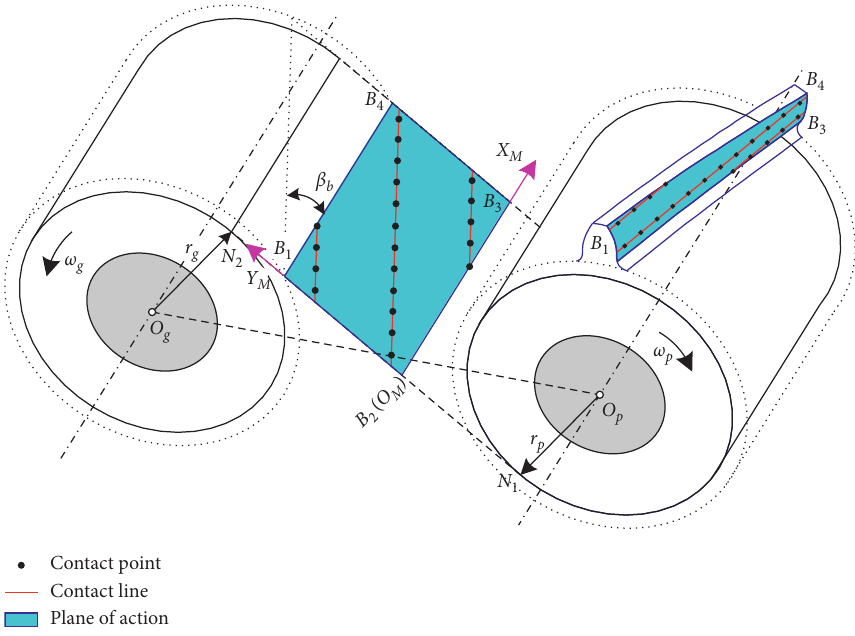
Figure 3: POA of a helical gear